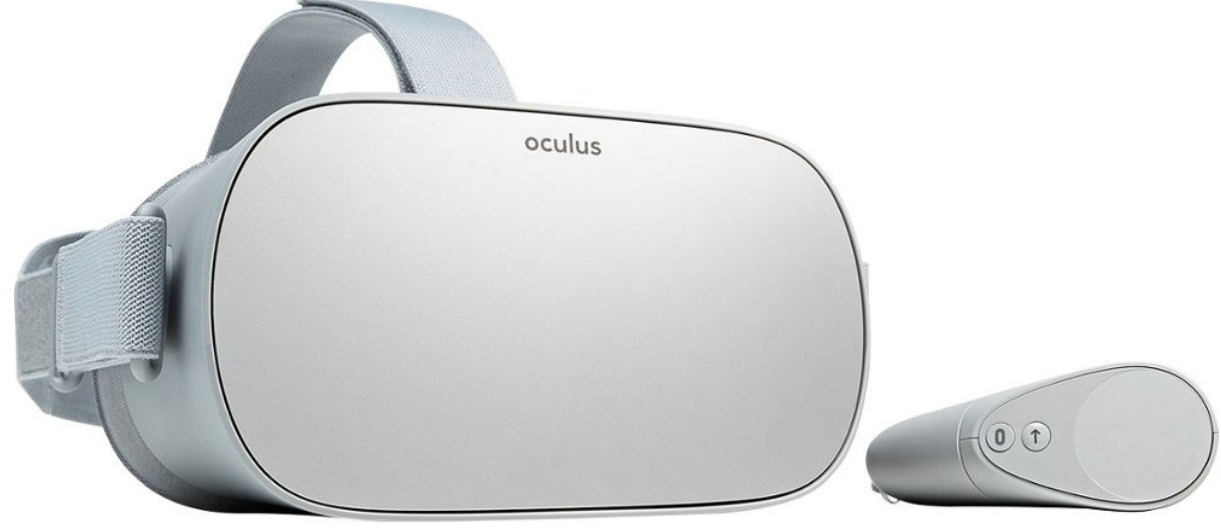
Figure 1. Oculus Go virtual reality headset.